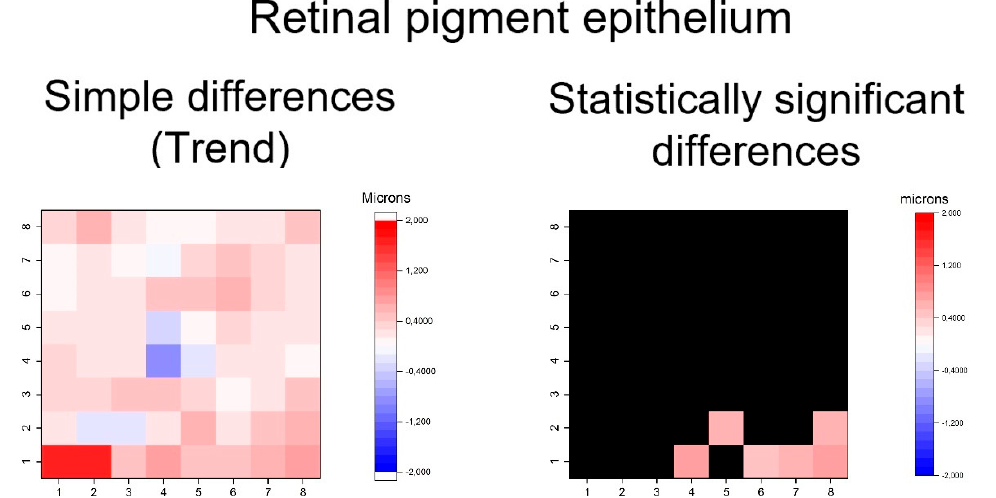
Figure 10. Heatmaps showing di ff erences in the retinal pigment epithelium layer. Left map: this heatmap represents simple di ff erences of mean thickness between OHT group and early POAG group in each superpixel giving an idea of the trend. Right map: the heatmap represents statistically significant di ff erences ( p < 0.05) of the mean thickness between groups in each superpixel. No significant di ff erence ( p ≥ 0.05) is represented in black. Range of significant OHT-POAG di ff erences in superpixels between 0.51 and 0.75 microns.